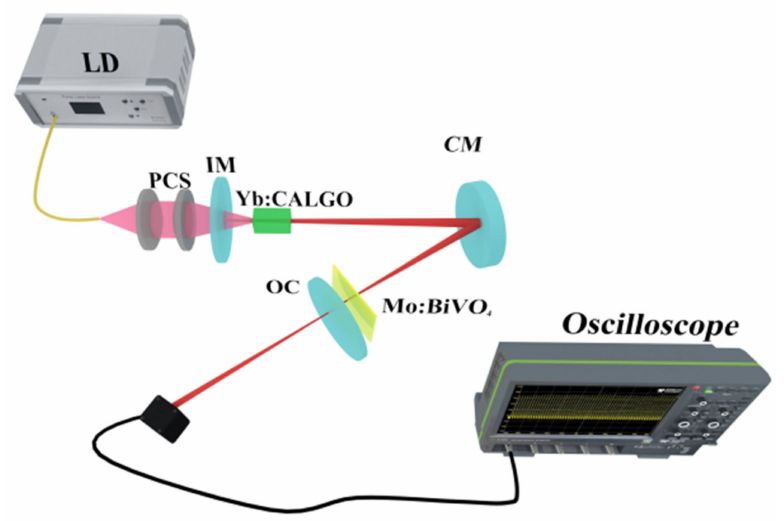
Figure 2. Draft of the CW and pulsed Yb:CALGO laser.